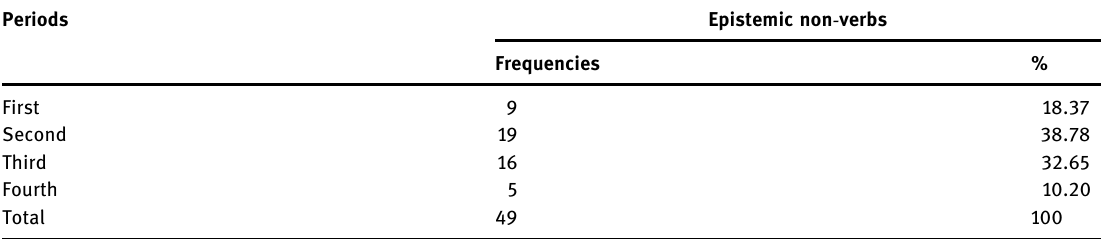
Table 11: Frequencies and percentages of epistemic non - verbs conveying personal opinions in the four time periods Periods